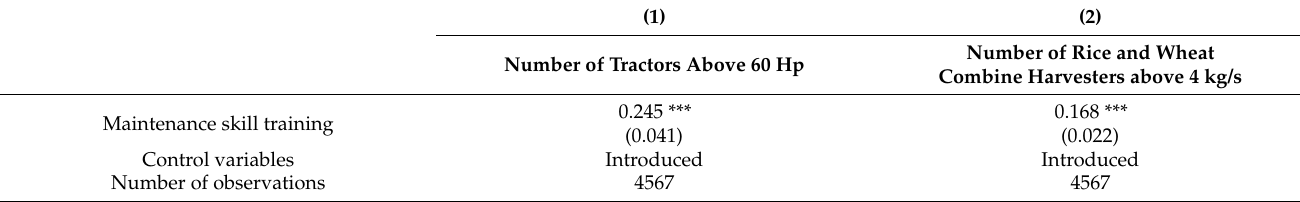
Table 6. Results of fixed effect model (amount of large- and middle-sized agricultural machinery).